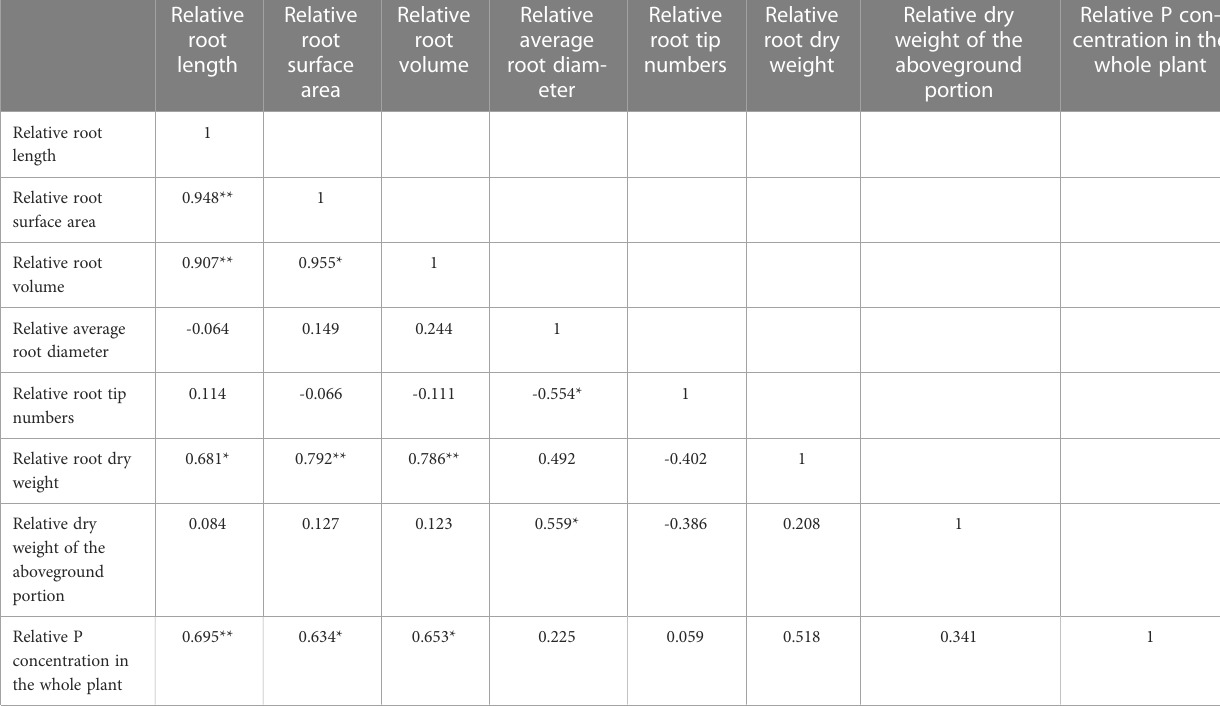
the L. corniculatus reference sequence lotus/summary3.0 (Table S4). Eight DEGs were randomly chosen for qRT-PCR validation (Figure 1). Their expression pro fi les were signi fi cantly associated with the RNA-seq data FPKM, validating the trustworthiness of the transcriptomic data (Table S5).